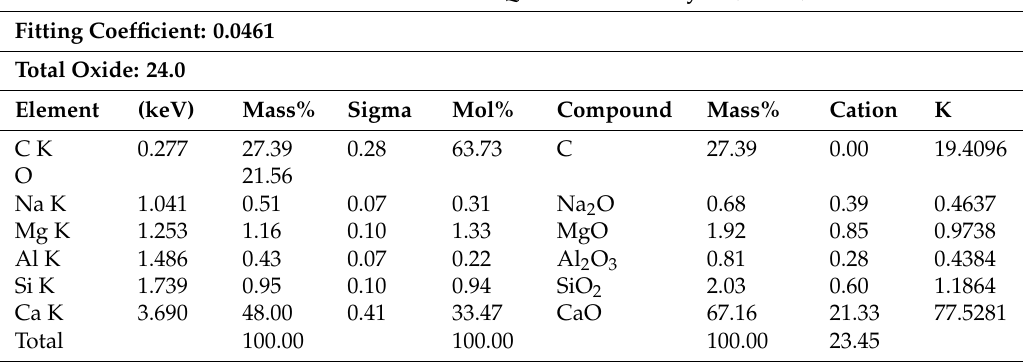
Table 4. Oxide analysis of Perna viridis Linn.